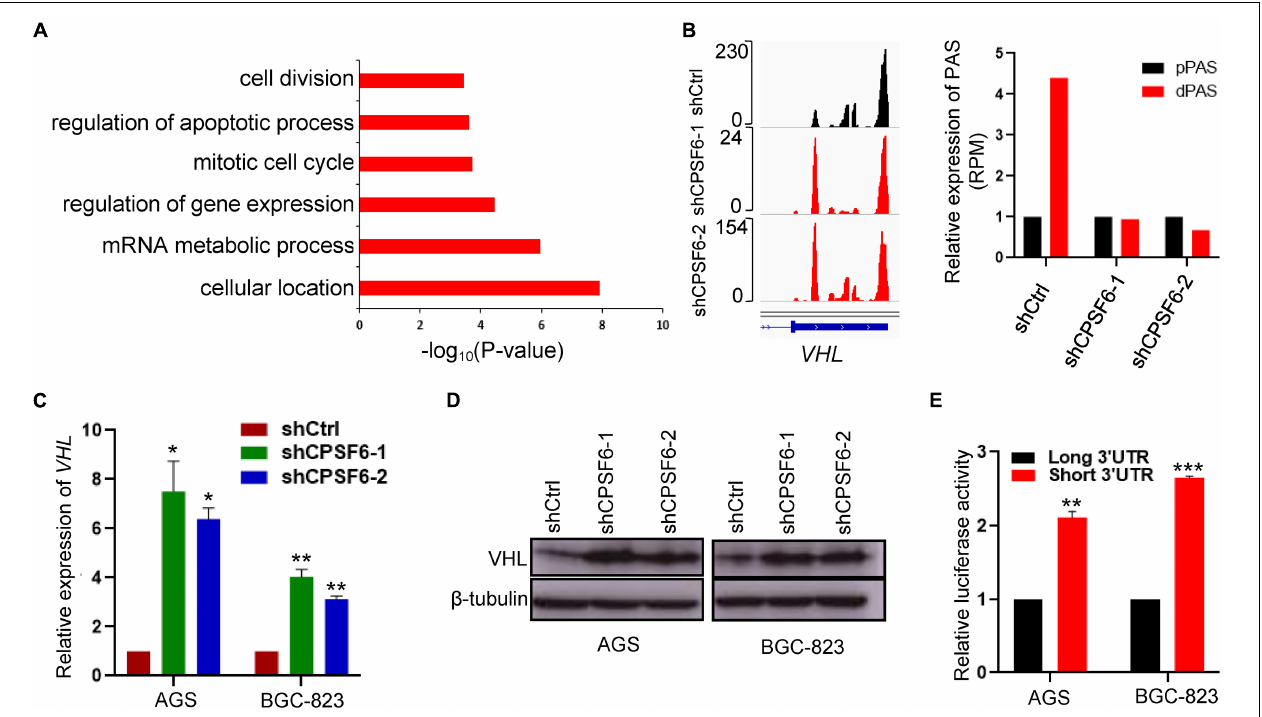
FIGURE 5 | CPSF6 downregulates the expression of VHL. (A) GO analysis of genes with shortened 3 (cid:48) UTR after knockdown of CPSF6 in AGS cells. (B) CPSF6 induced APA shift of VHL . Left, Integrative Genomics Viewer (IGV) genome browser exhibited the poly(A) site usage of VHL 3 (cid:48) UTR. Right, histogram showed the relative expression of the isoform with distal polyadenylation site (dPAS) relative to the one with proximal PAS (pPAS). (C) The mRNA levels of VHL in CPSF6 knockdown AGS and BGC-823 cells. (D) The protein levels of VHL in CPSF6 knockdown AGS and BGC-823 cells. (E) The luciferase reporter assay for the expression activity of the isoform of VHL 3 (cid:48) UTR in AGS and BGC-823 cells. *0.01 < p < 0.05; **0.001 < p < 0.01; *** p <